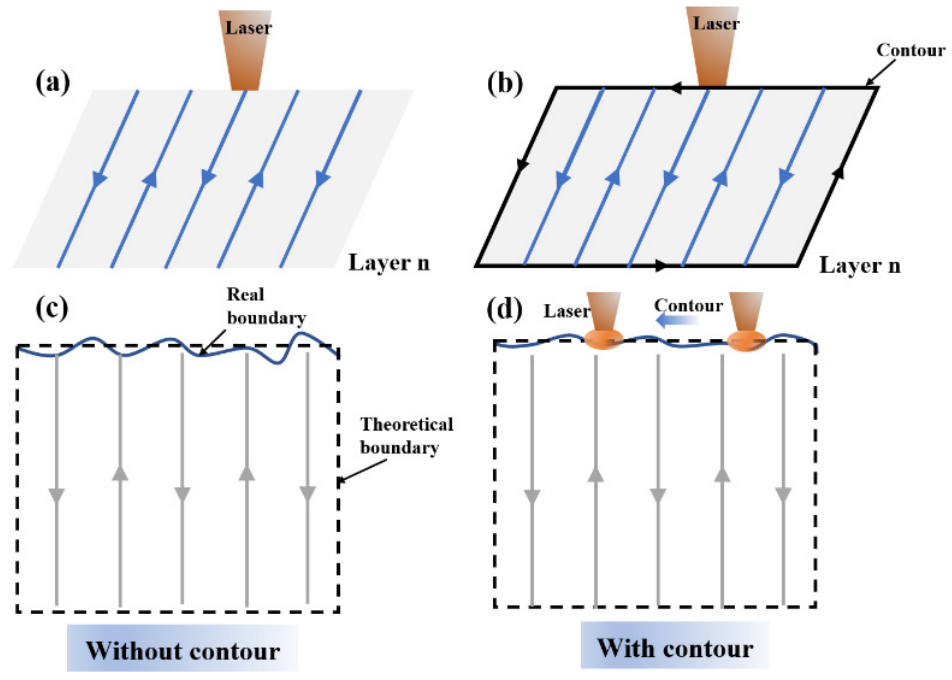
Figure 3. Schematic diagram of the contour scan strategy: ( a , c ) without contour, ( b , d ) with contour. Therefore, after the up-facing skin parameters were optimized, the contour parameters, including contour scanning speed and contour offset, were studied. The three factors and five levels in the orthogonal test table (L 25 (5 3 )) are provided in Table